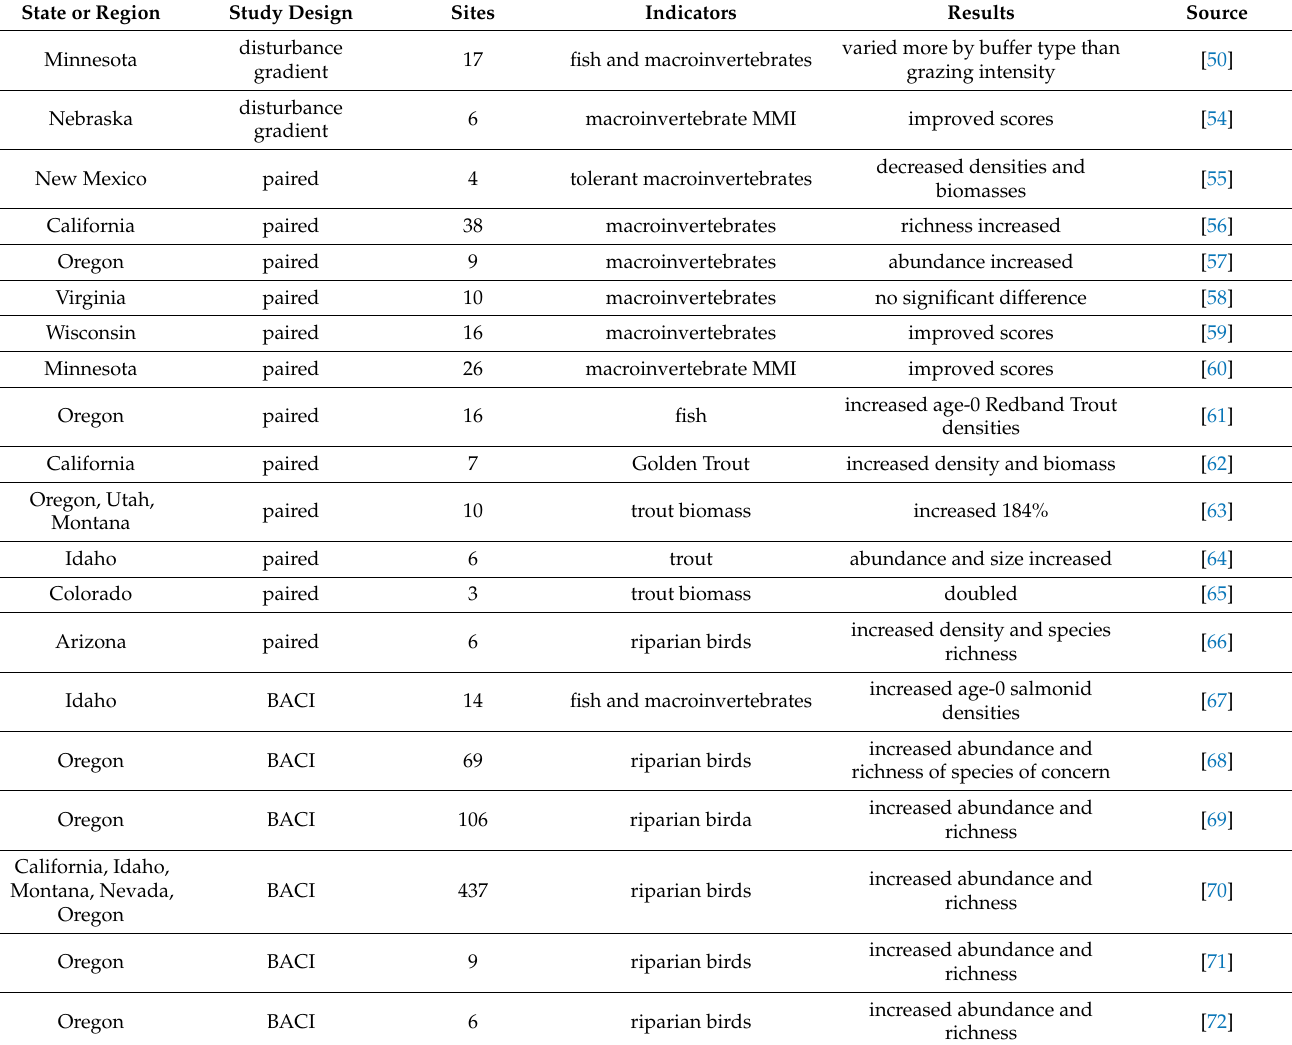
Table 2. Case studies of the effects of livestock exclosures on stream/riparian